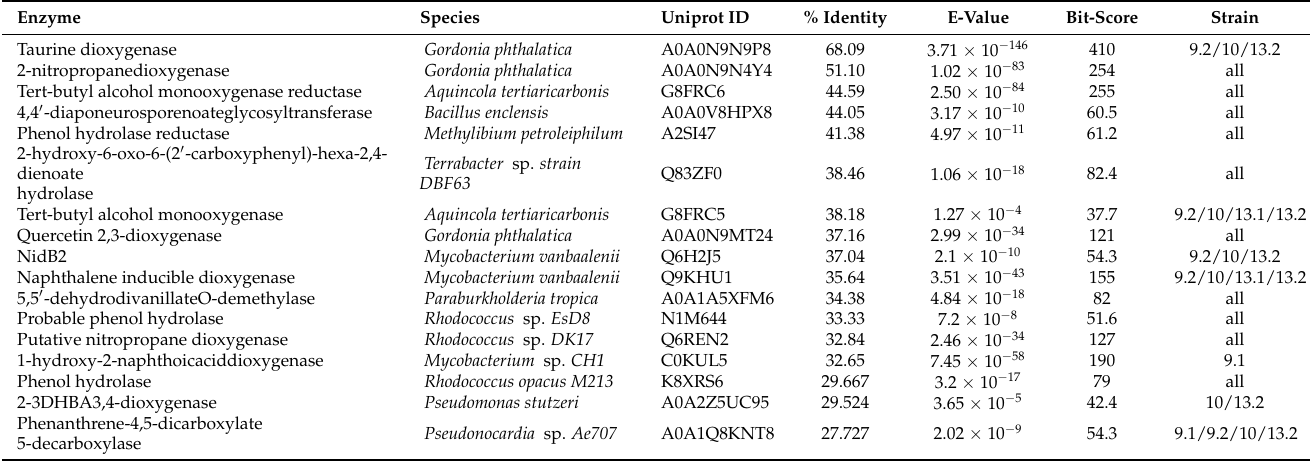
Table 2. Predicted plasticizer and other xenobiotic biodegradation genes with significant percentage identity and similarity to genes encoded in strains within the full